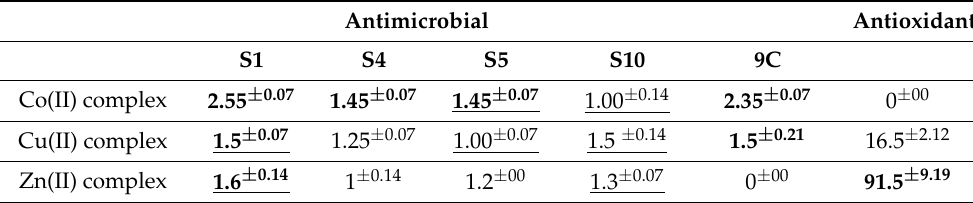
Table 4. Antimicrobial and antioxidant effects. (Inhibitory zone expressed in cm ± SD). Antimicrobial